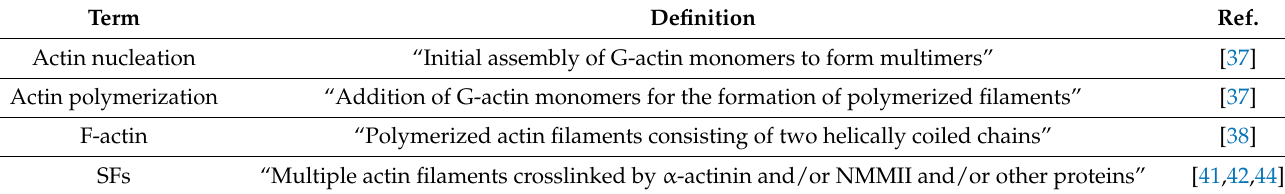
Table 1. Definition of terms regarding the actin